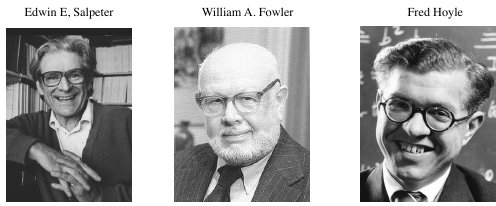
Figure 1: The dominant personalities involved in this story: The discovery of the triple α